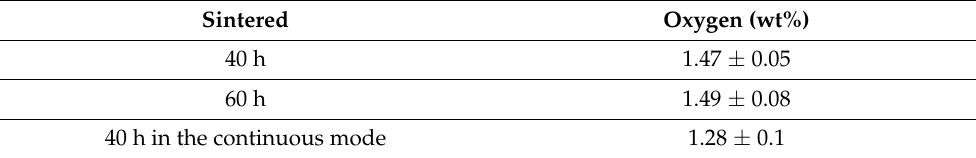
Table 7. Oxygen content of the sintered